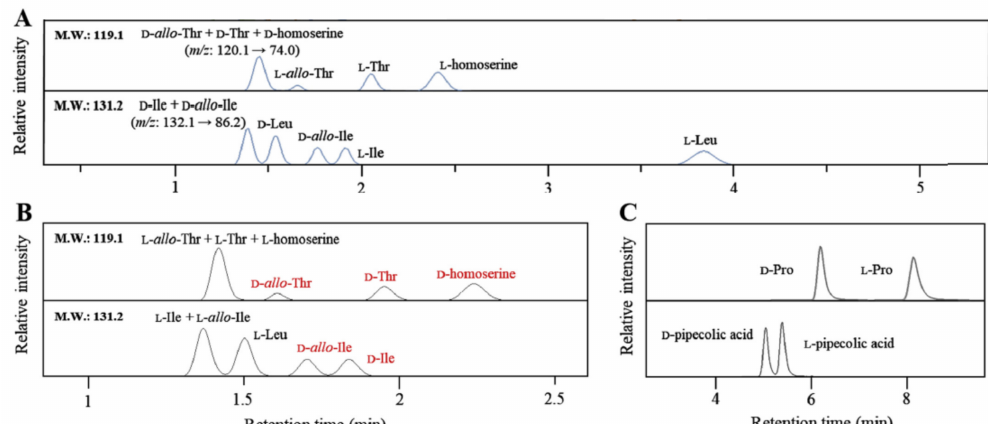
Figure 6. The chromatograms obtained by Crownpak CR-I (+), CR-I ( − ) and Chiralpak ZWIX ( − ). ( A ) Partial chromatograms of targeted compounds with the same molecular weight obtained by LC-MS/MS analysis using Crownpak CR-I (+). These chromatograms were obtained from a 1 nmol/mL mix standard solution (Thr, threonine; Ile, isoleucine; and Leu, leucine). The same color peaks were detected in the same MRM transition. Most compounds showed baseline separation while some compounds including D - allo -Thr, D -Thr, and D -homoserine or D -Ile and D - allo -Ile co-eluted. ( B ) Extracted ion chromatograms using Crownpak CR-I ( − ). The chromatogram for the MRM transition of m/z 120.1 to 74.0 (molecular weight: 119.1) and 132.1 to 86.2 (molecular weight: 131.2). The CR-I ( − ) column reversed the elution order for each compound from the CR-I (+) column. ( C ) A part of chromatogram of secondary amines by using Chiralpak ZWIX ( − ). The ZWIX column, with zwitterionic molecules that incorporated both anion and cation-exchange functional groups, enabled the separation of secondary amines including proline (Pro). Adapted from the work in [82] with permission.